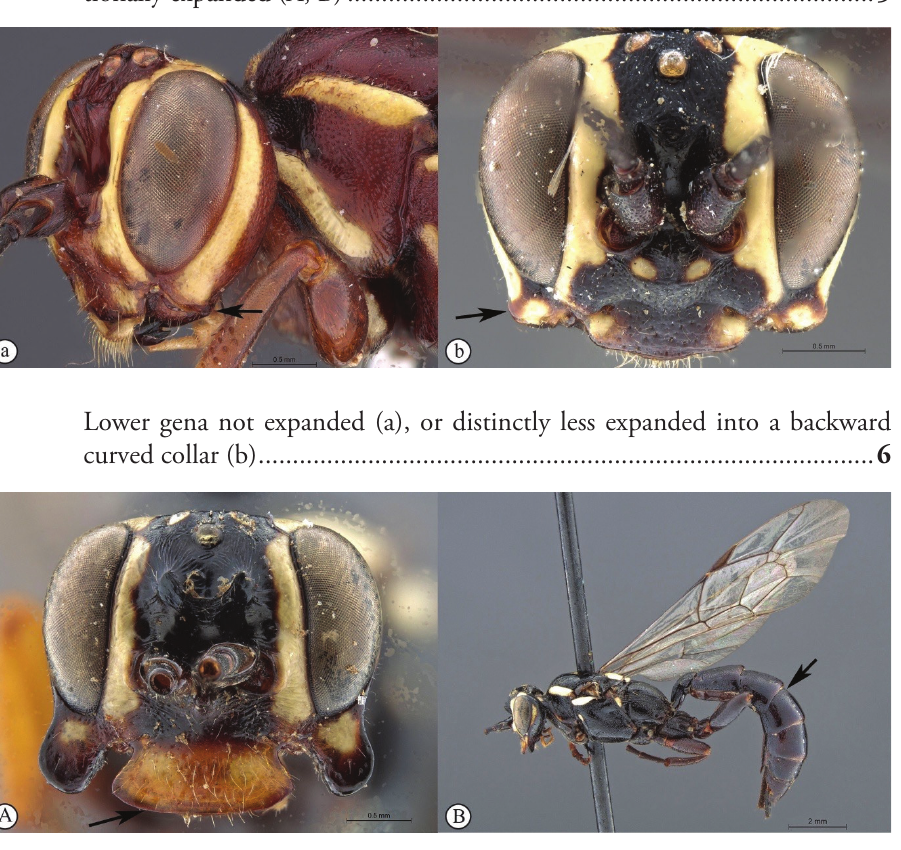
Clypeus apically slightly convex, gena moderately protruded (A);